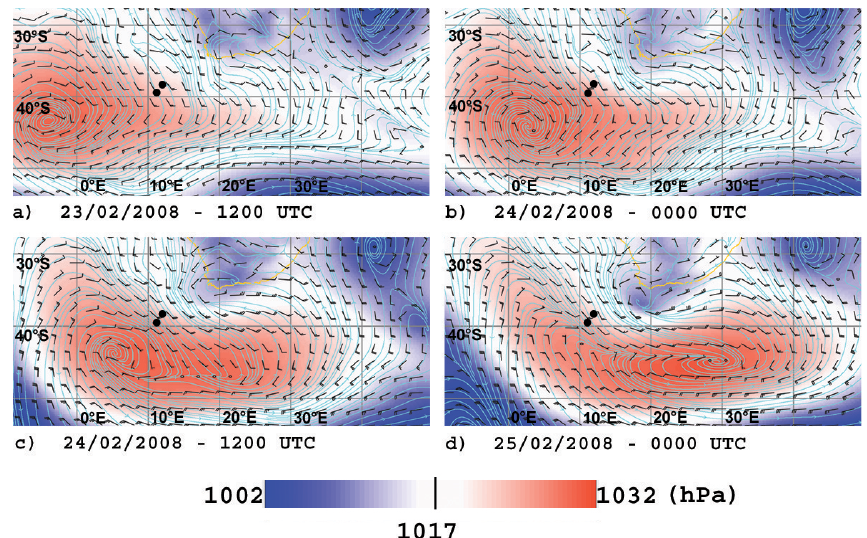
Fig. 9. Synoptic situation when the ship crossed the STF (from ECMWF ERA interim reanalysis). Colored background is the medium sea level pressure, light blue isolines are streamlines at 10m height. Wind barbs (in knots) are overlaid. Black points indicate the rs1 and rs2 release locations. Brown line is the South African coastline.